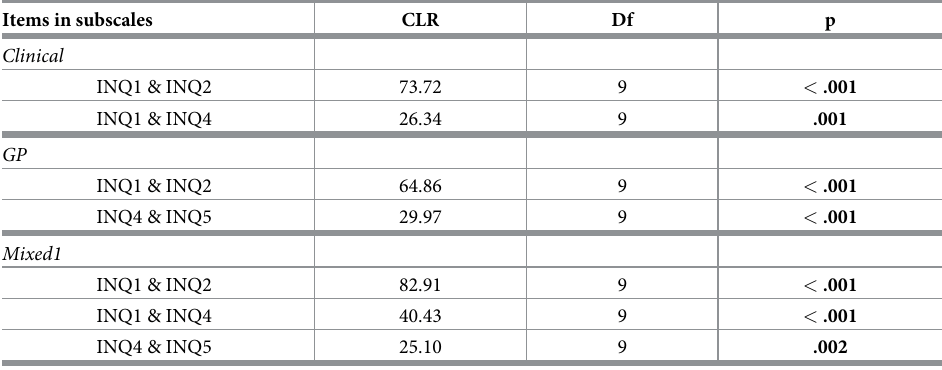
Table 4. Conditional likelihood ratio tests of local dependence under the respective GLLRMs for the PB-subscale. Items in subscales